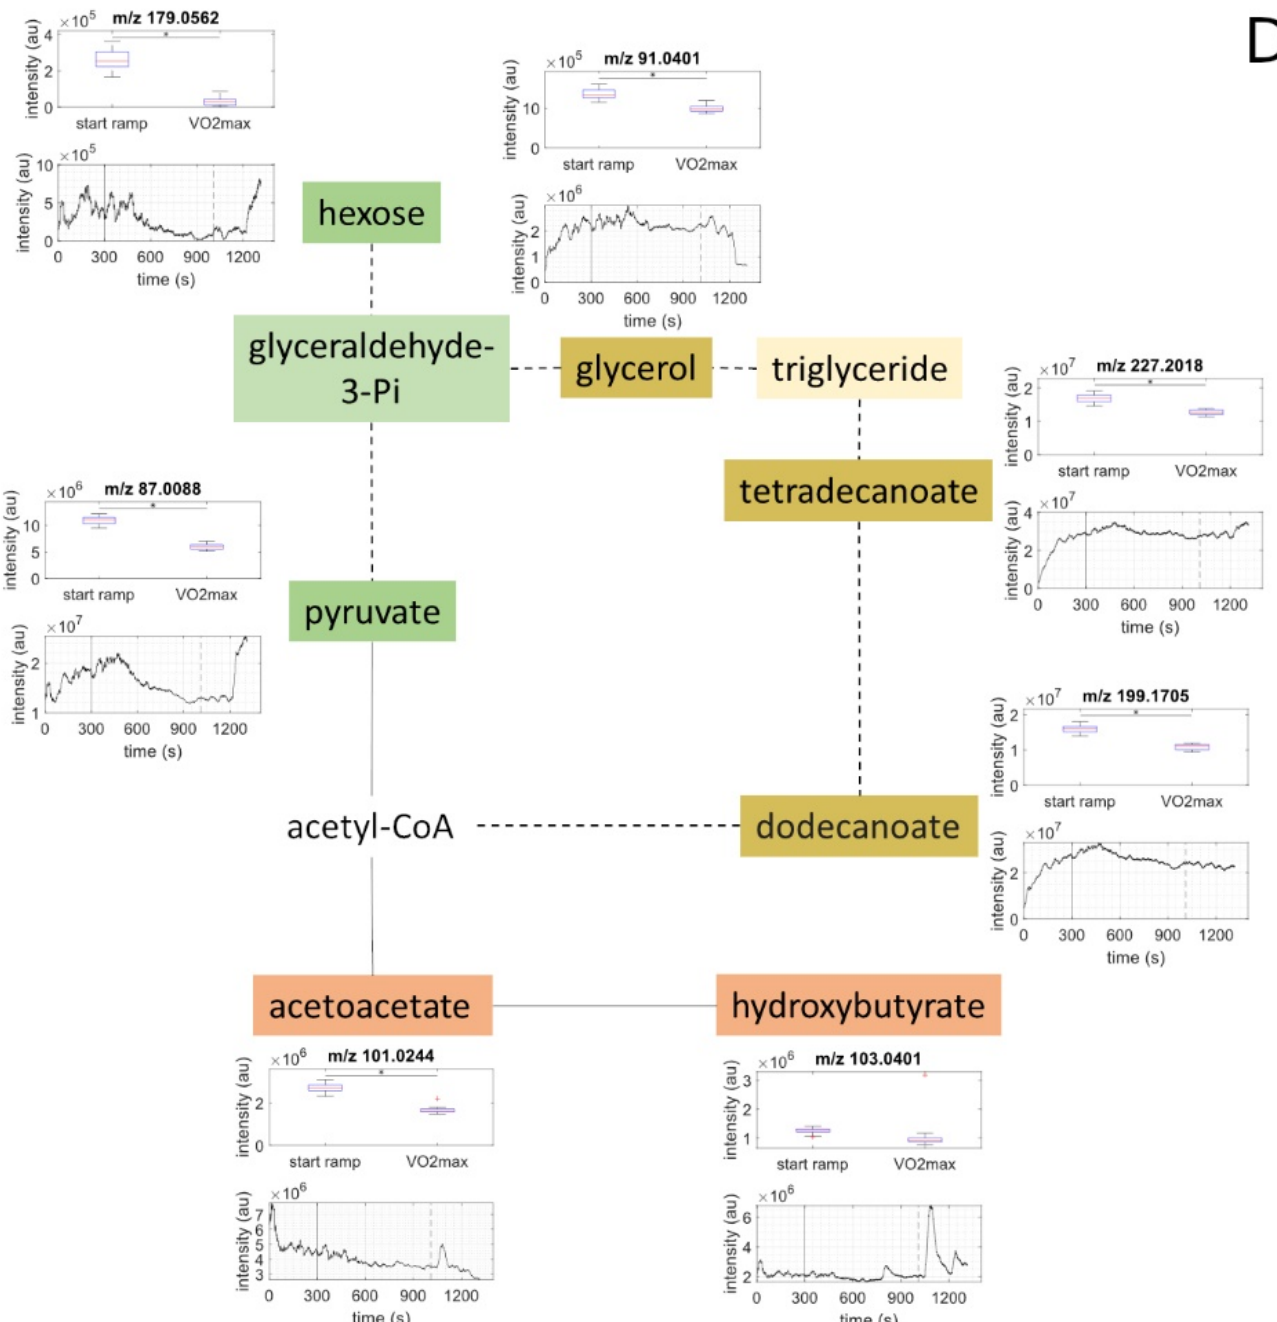
Figure 1. Metabolic pathways map. Metabolites that were identified in exhaled breath are marked with dark colour, while lighter colors are used for unidentified metabolites that demarcate important points in the pathways. Pathways including metabolites that decreased significantly between the start of the ramp and VO2max are: ( A ): blue for glyoxylate metabolism; ( B ): yellow for TCA cycle; and ( C ): grey-blue for tryptophan metabolism. Trends for changes in metabolite intensities are marked with arrows. Furthermore, ( D ): glycolysis is marked in green, lipid metabolism in brown, and ketone pathway in red. Summary data for each identified metabolite are represented with box plots (with median, quartiles, maxima and outliers) using intensities for all subjects from the start on the ramp to VO2max. Continuous intensity data over time are represented from one sample subject (subject 6).